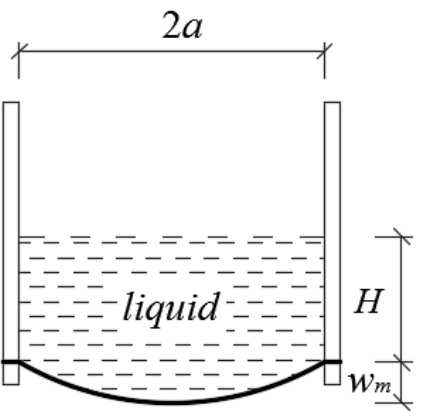
coordinate, w denotes the axial coordinate of the cylindrical coordinate system ( r , ϕ , w ) as well as the transverse displacement of a point on the deflected circular membrane, θ denotes the slope angle of the deflecting membrane, and σ r denotes the radial stress, while the angle coordinate ϕ is not represented in Figure 2.